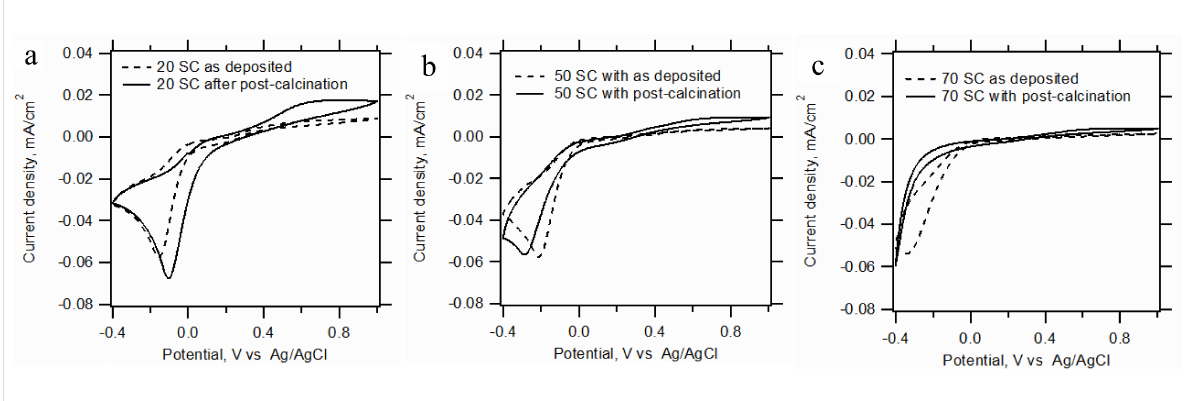
Figure 6: Cyclic voltammograms on a FTO(B) substrate covered by TiO 2 films of (a) 20 SCs, (b) 50 SCs and (c) 70 SCs of 0.2 M TAA. Scan rate 50 mV/s. Electrolyte solution was 0.5 mM Fe(CN) 63 − /4 − in aqueous 0.5 M KCl, pH